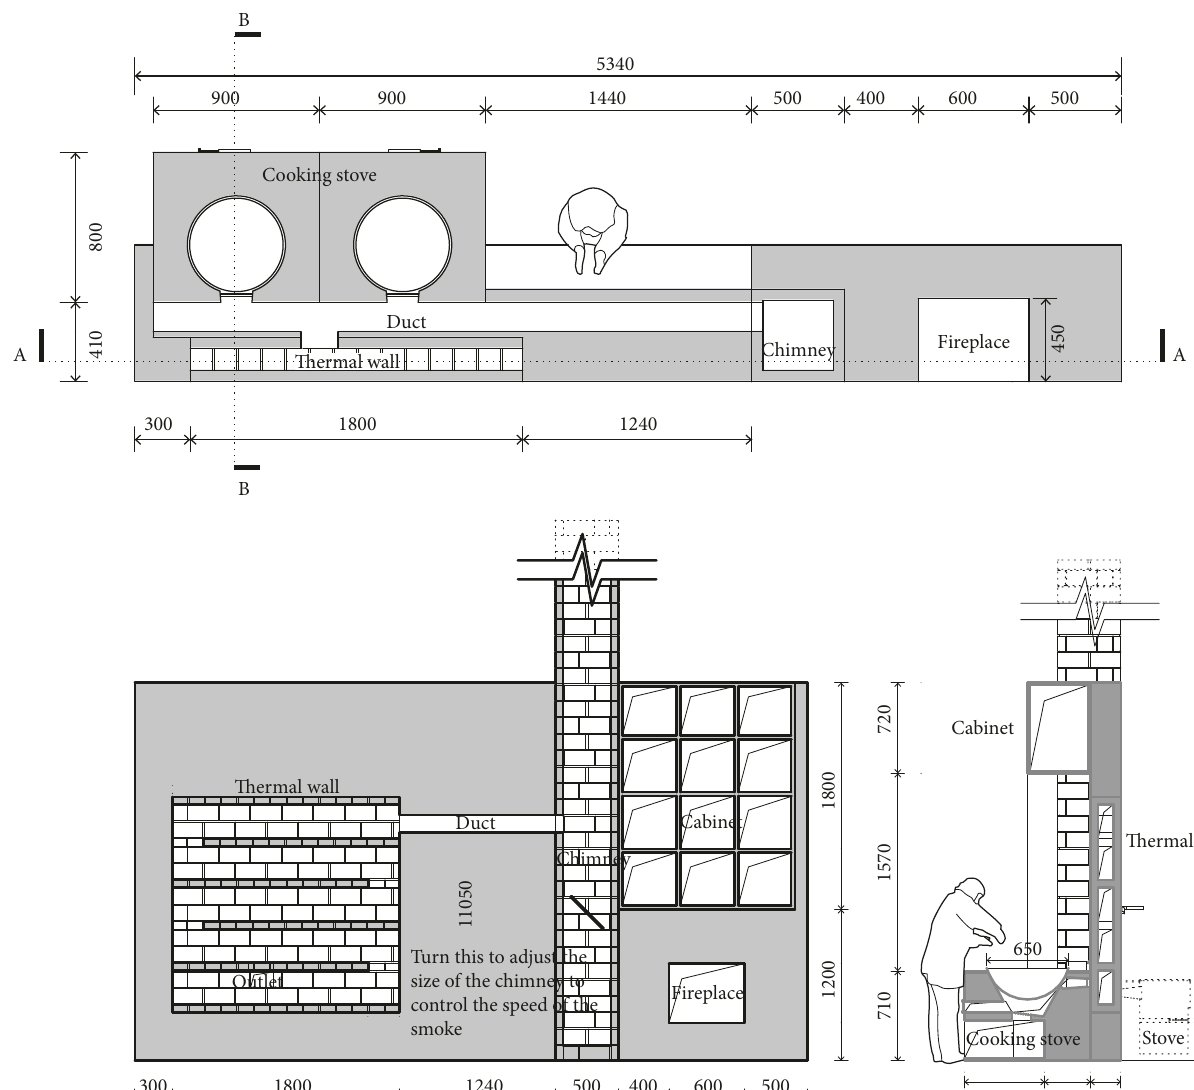
Figure 3: The proposed heat recovery system for potential use in rural areas of central